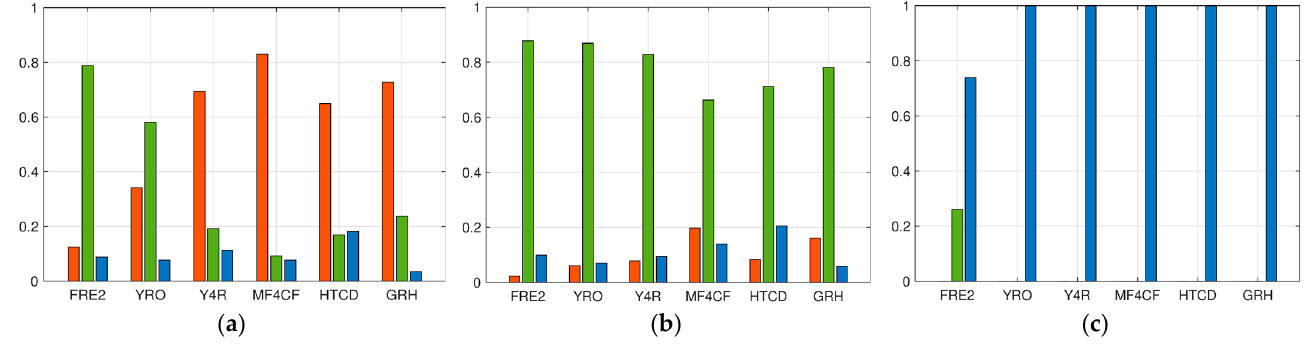
Figure 7. Bar charts of polarimetric target decomposition results. Red: double-bounce scattering ( Pd ). Green: volume scattering ( Pv ). Blue: surface scattering ( Ps ). ( a ) Results of decomposition of urban area; ( b ) Results of decomposition of vegetation area; ( c ) Results of decomposition of ocean area. Table 4. The percentage of negative power pixels for each algorithm (%).